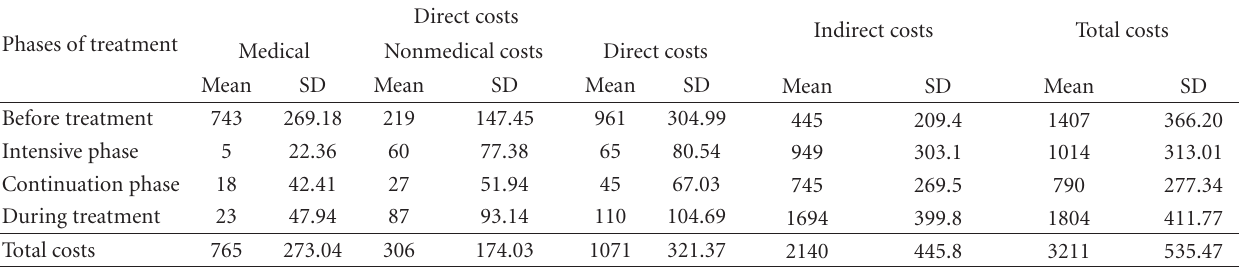
Table 2: Direct, indirect, and total costs incurred by patients during di ff erent phases of treatment ( n = 300). Phases of